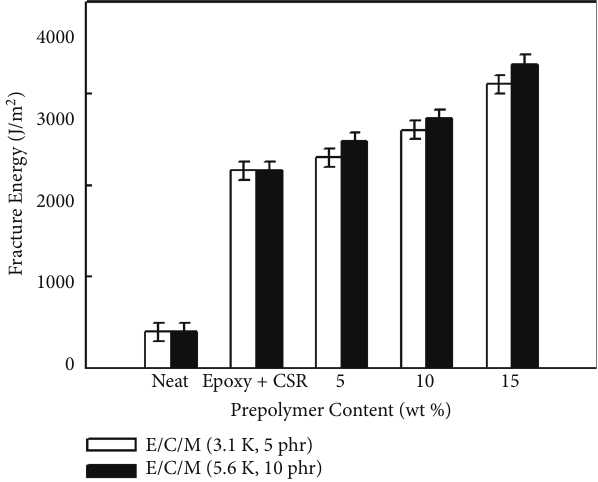
E/C/M (3.1 K, 5 phr) E/C/M (5.6 K, 10 Figure 6: Comparison plot of fracture energy between E/C/M (3.1 K) and E/C/M (5.6K) epoxy resins using di ff erent MPB